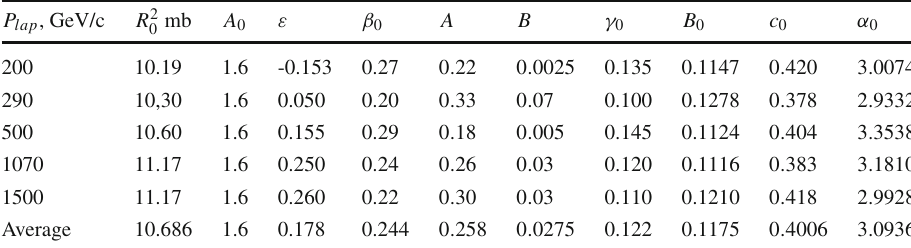
Table 1 The dimensionless (cid:5) (cid:6) / r 2 values of α 0 = R 2 , 0 p two-quark force parameters A 0 , ε and β 0 , three–quark force parameters A , B and γ 0 and cloud parameters B 0 and c